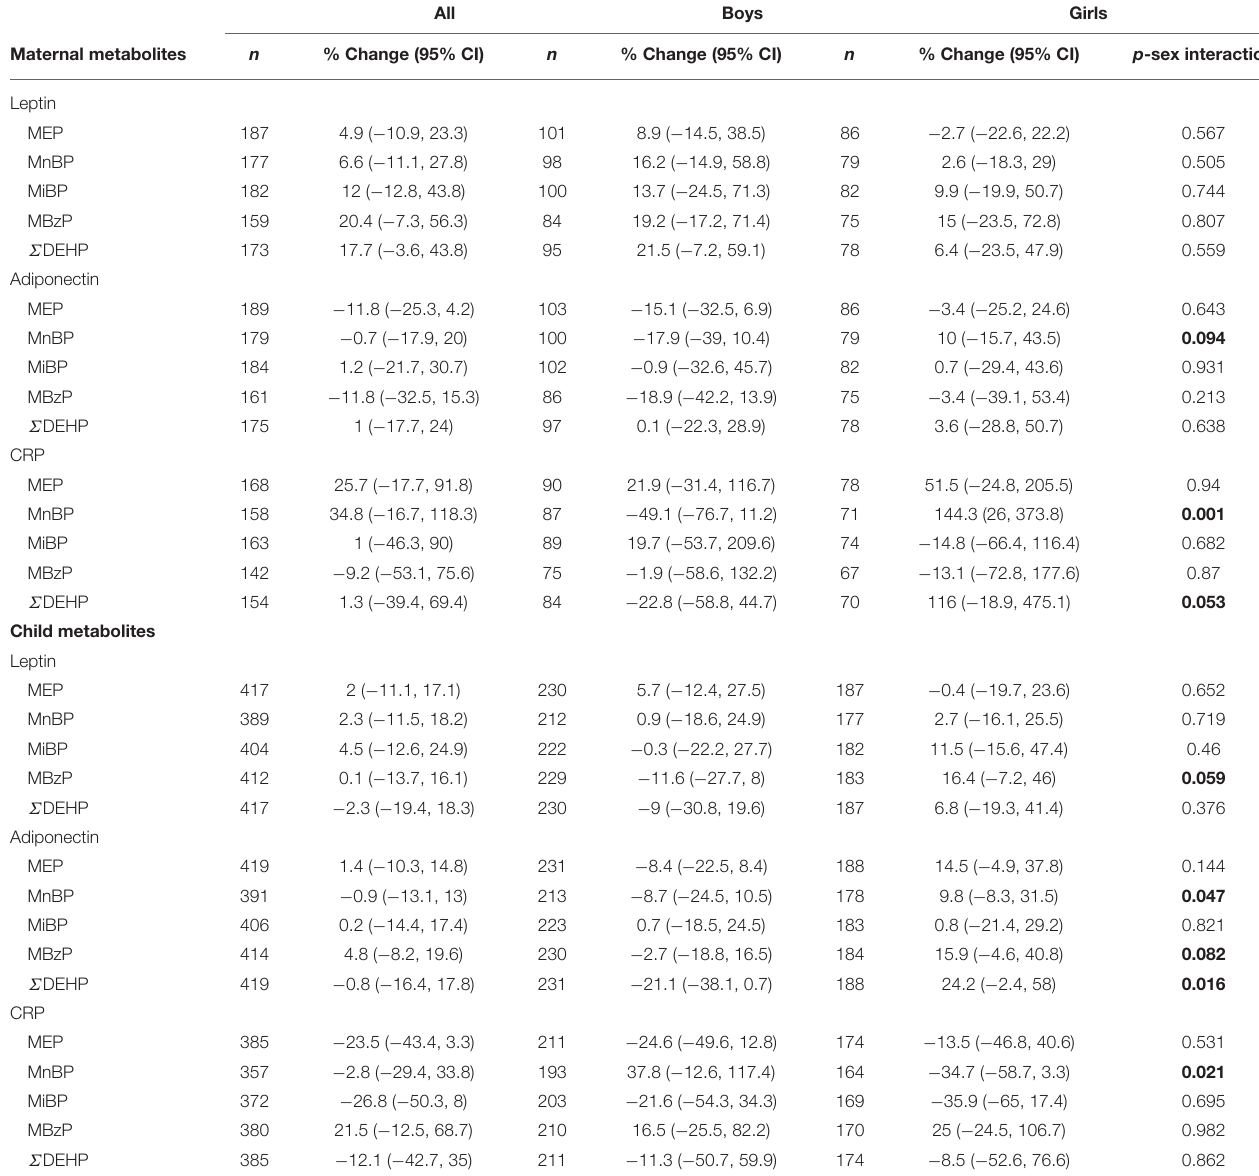
TABLE 5 | Sex-stratified associations between maternal and child urinary individual and summed Σ DEHP phthalate metabolites (log 10 Transformed, in µ g/g Creatinine) with leptin, adiponectin and CRP levels in children aged 4 years. All Boys